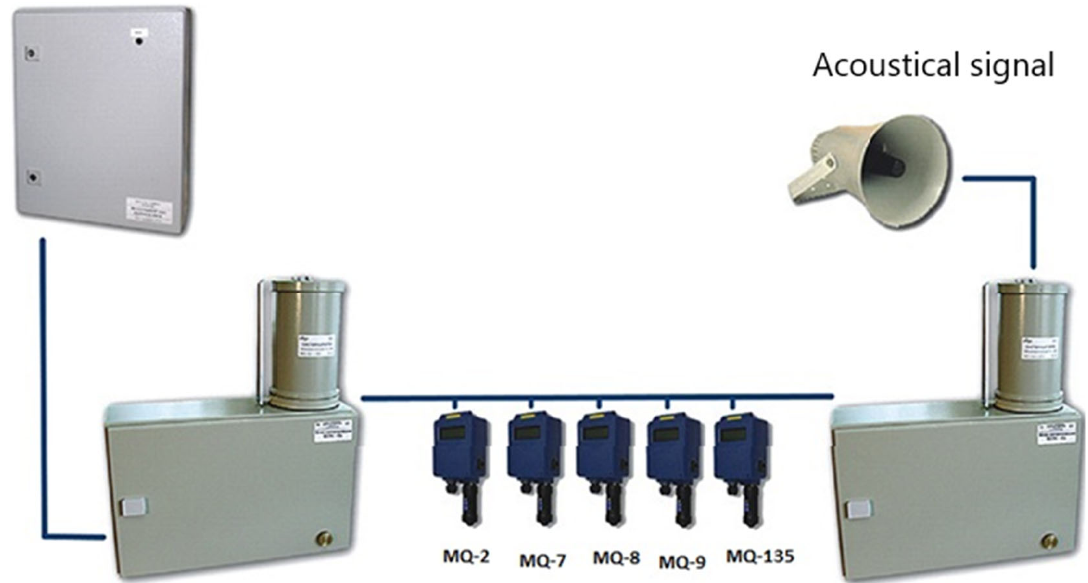
Figure 1. The scheme of the sensors connecting.